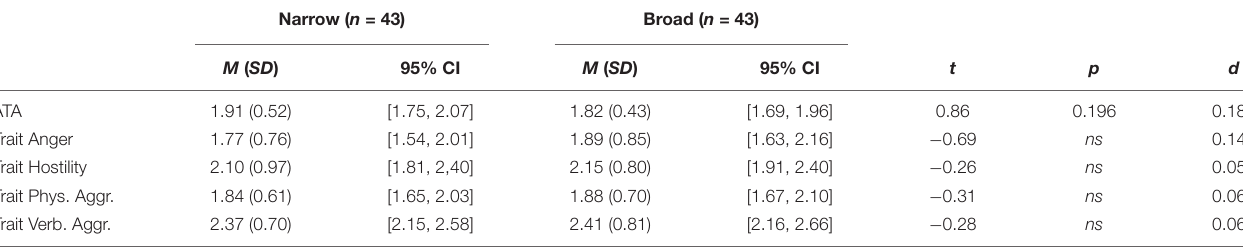
TABLE 3 | Effect of cognitive scope condition on attitudes toward anger and trait aggression subscales – Study